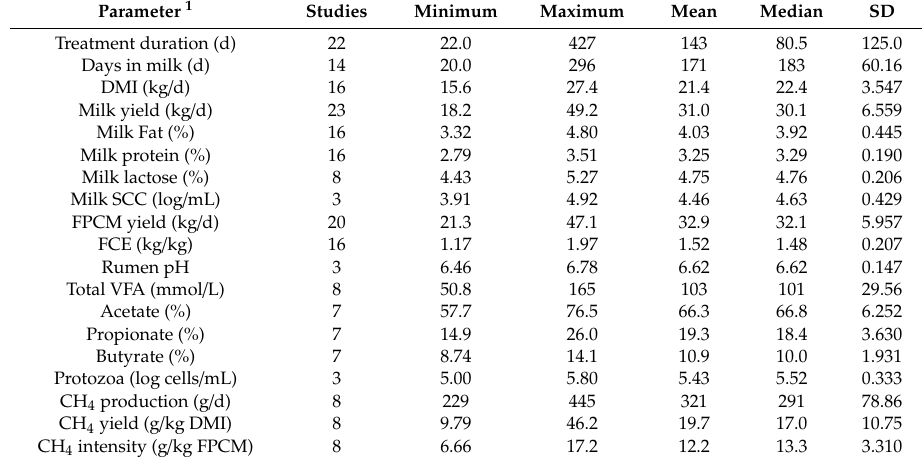
Table 2. Descriptive statistics of the parameters included in the